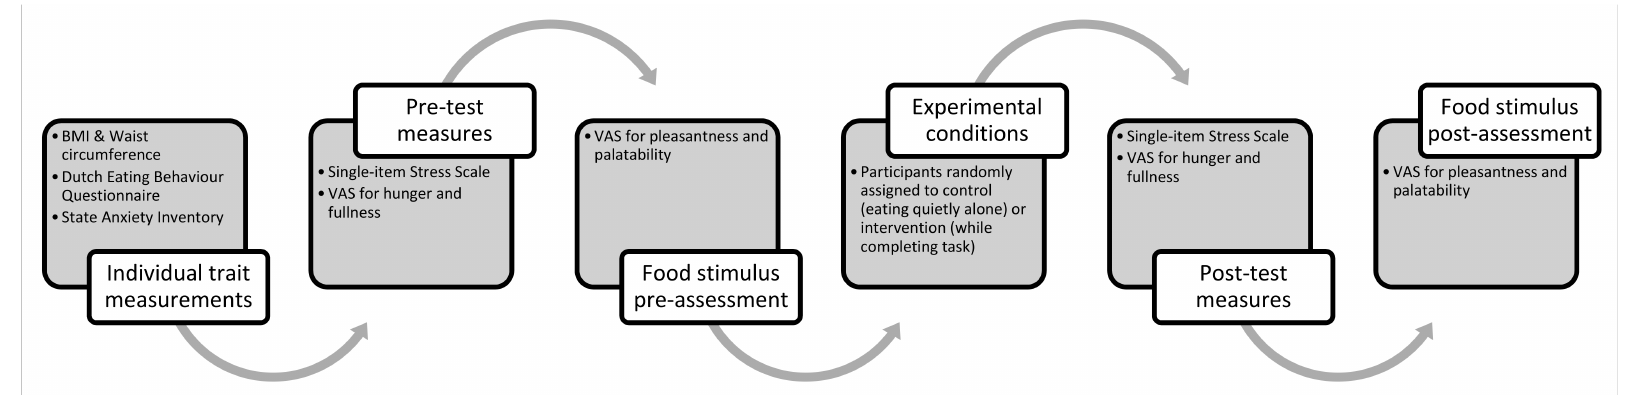
Figure 1. Overview of the experimental